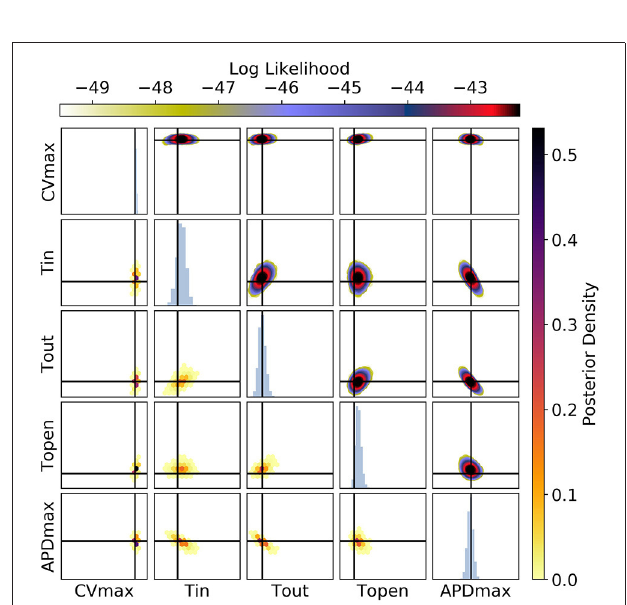
FIGURE 13 | The posterior parameter distribution for calibration to CV(S2), APD(S2), and ERP(S1) measurements simultaneously. The intersection of vertical and horizontal lines mark the true parameter value. The lower diagonal shows the density via hexbin plots, while the upper diagonal shows the log likelihood values for each sample plotted in order of increasing likelihood. The diagonals show the marginal histograms of each